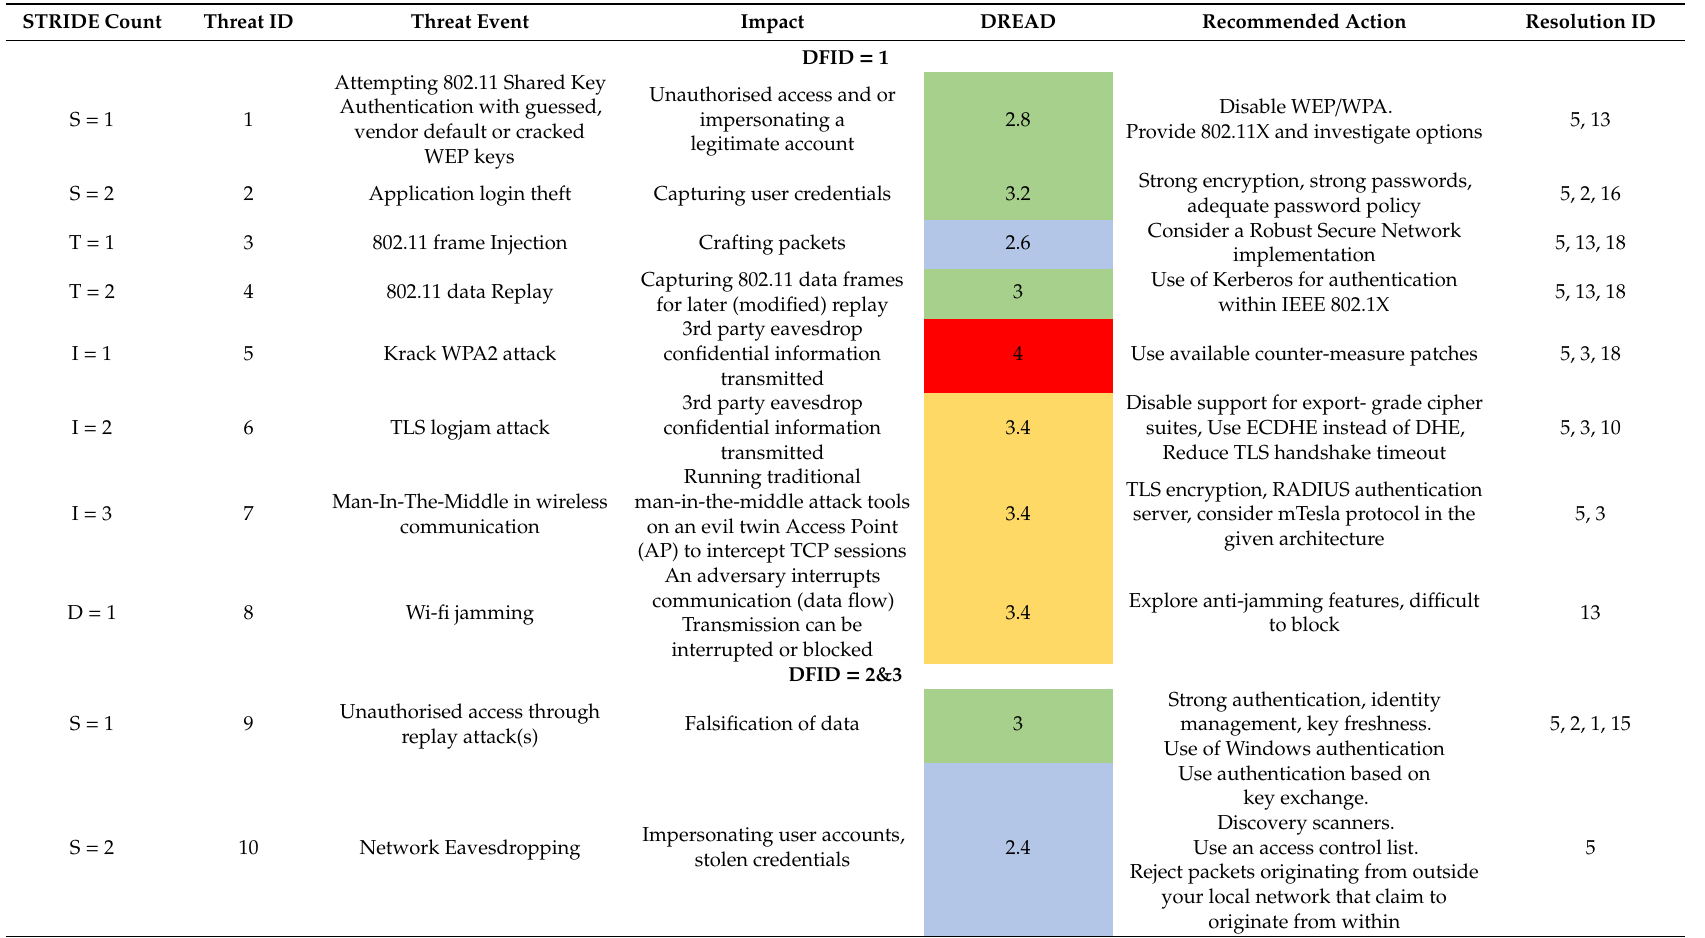
Table 4. Recommendations and resolutions for threats of database